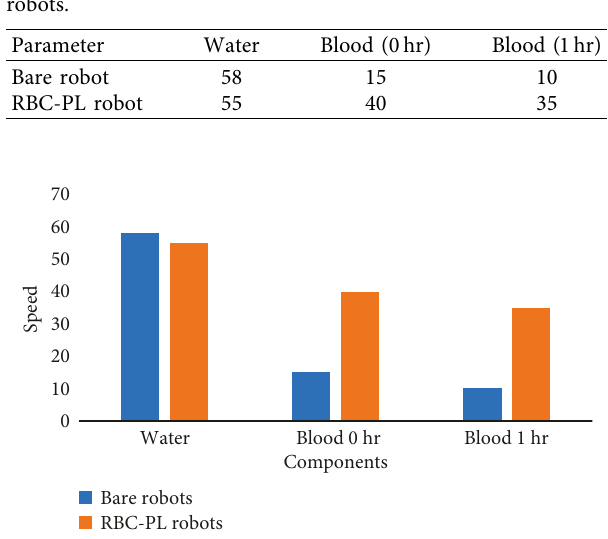
Figure 6: Bare robots speed comparison.